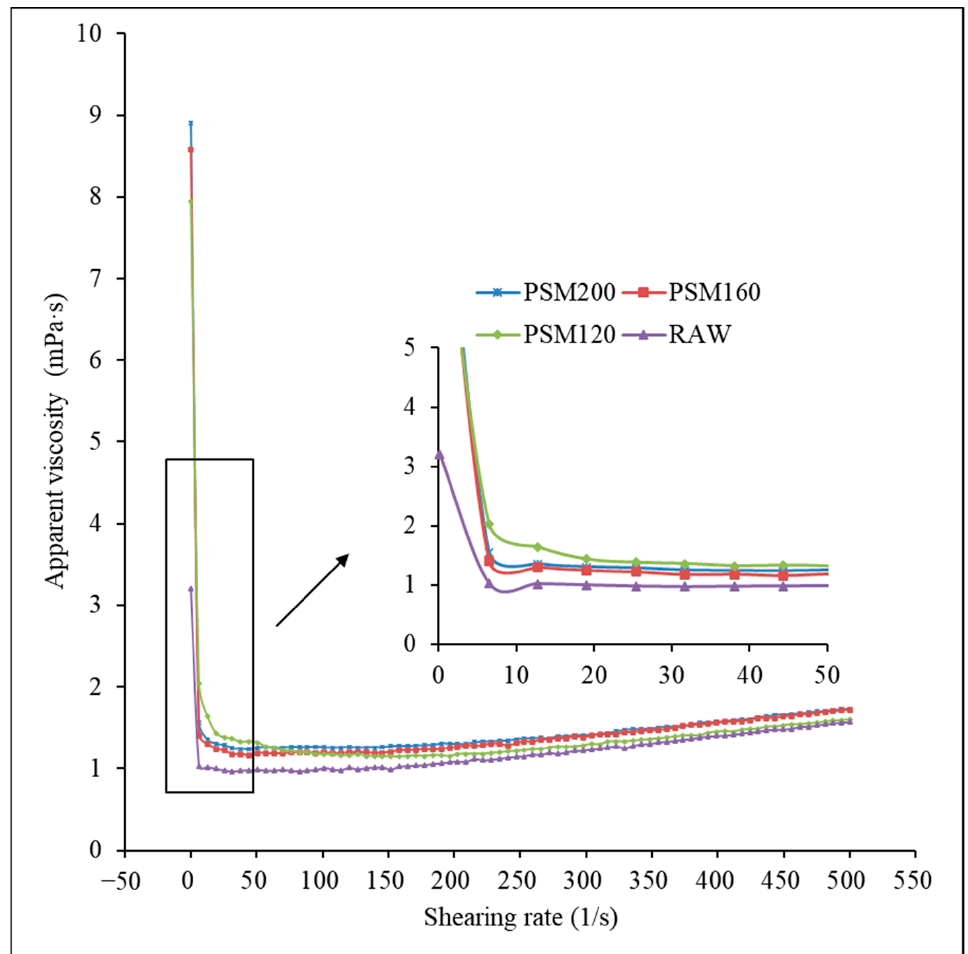
Figure 4. Rheology of pumpkin seed milk prepared with different pumpkin seeds. RAW: raw pumpkin seeds, PSM120: pumpkin seeds roasted at 120 °C, PSM160: pumpkin seeds roasted at 160 °C, and PSM200: pumpkin seeds roasted at 200 °C.